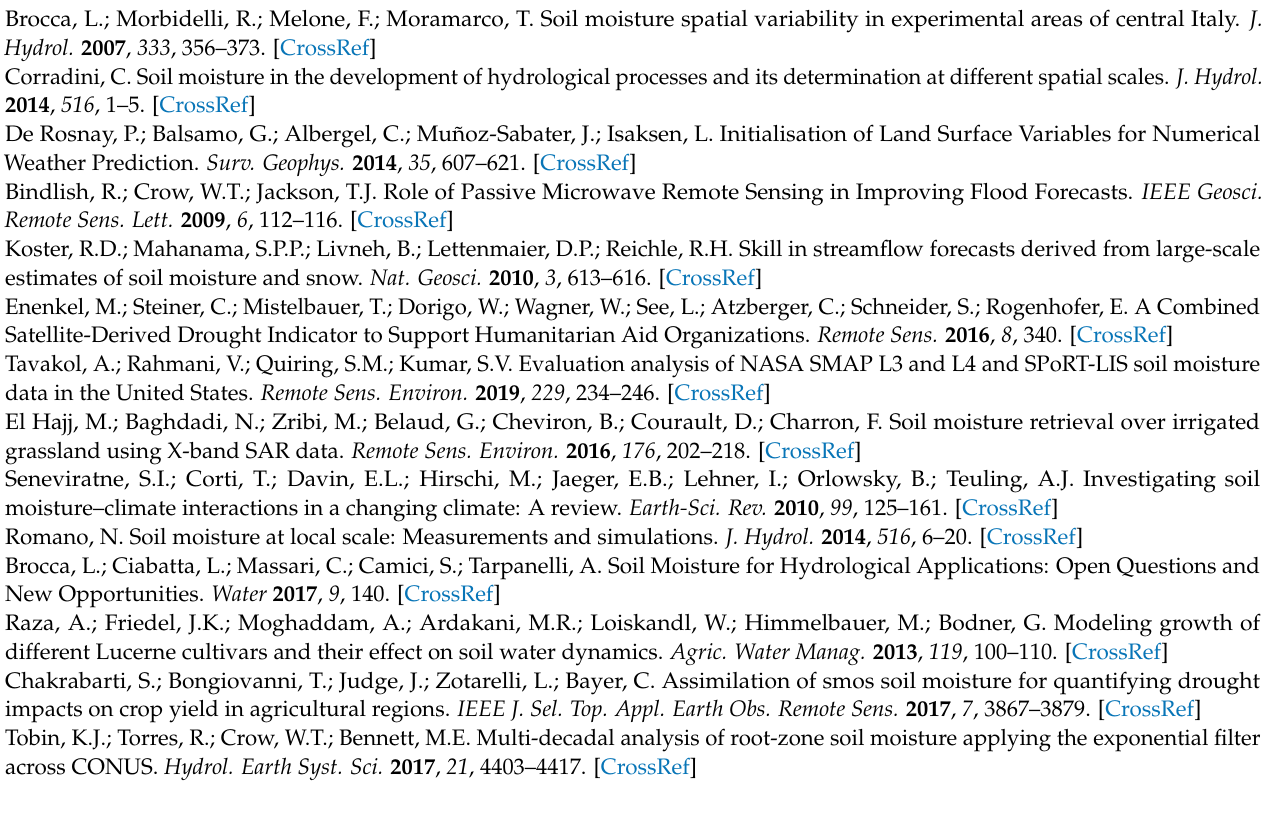
Figure S2: Covering scale of SMAPL3-derived (a) and SMAPL4-provided (b) RZSM datasets at the same time (at 00:00 UTC) within the study